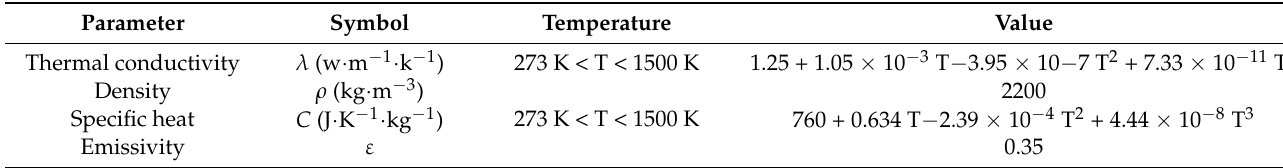
Table 2. Physical properties of quartz crucible